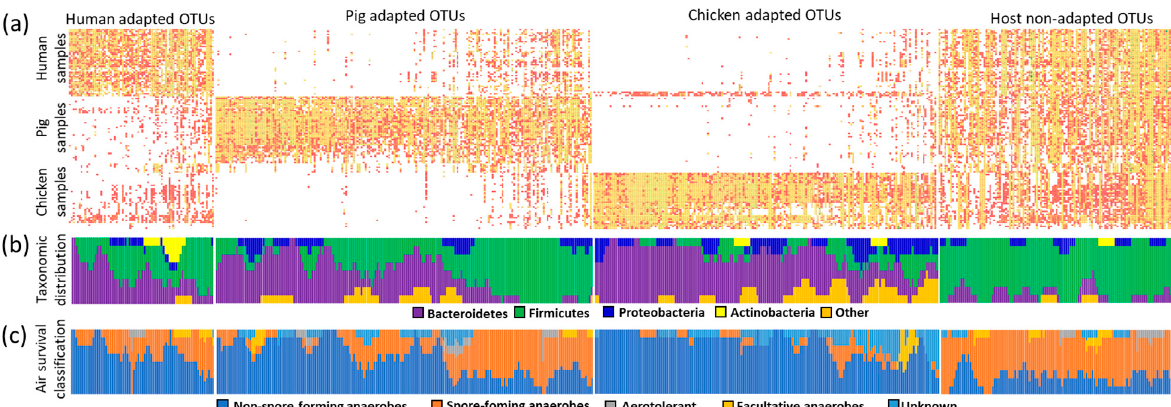
Figure 4. Host adaptation based on presence and absence classification. Panel ( a ), classification of OTUs as human-, pig- and chicken-adapted, or non-adapted. Each dot indicates presence of given OTU in a particular sample of human, pig or chicken origin. Heat map was used to indicate the abundance with red colour indicating abundance lower than 0.1% and yellow colour indicating abundance higher than 0.1%. Host-adapted OTUs are arranged according to the strength of their host adaptation with OTUs more to the right being present also in the non-preferred host. Panel ( b ), classification of OTUs from panel ( a ) into 4 main phyla. A sliding window of 8 OTUs was used to calculate the ratio of OTUs belonging to Bacteroidetes (magenta), Firmicutes (green), Proteobacteria (blue), Actinobacteria (yellow) and other phyla (orange). Panel ( c ), the same sliding window protocol was used but each OTU was classified as either belonging to non-spore forming (blue), spore- forming (orange), facultative anaerobe (yellow), aerotolerant (grey) and other OTUs with unknown relationship to oxygen tolerance (light blue). Classification of each OTU into spore-forming, non- spore-forming, aerotolerant or facultative anaerobe can be found in Table S3.